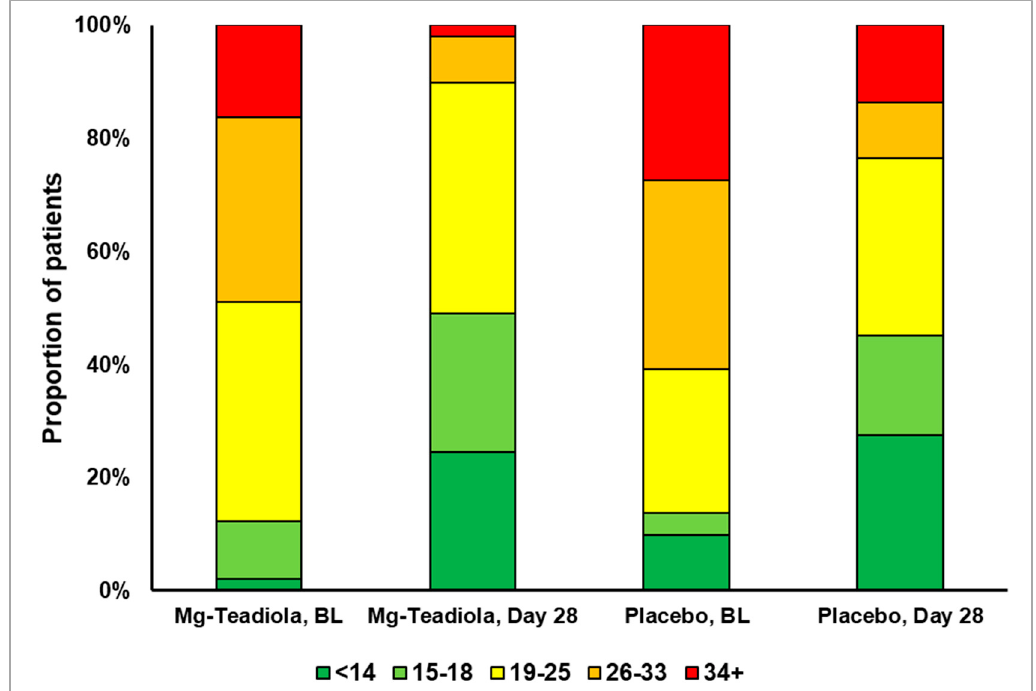
Figure 3. Proportion of participants with change in DASS-42 stress scores over time. BL, baseline; DASS, Depression Anxiety Stress Scale. Stress scores ranges: 0–14 (normal), 15–18 (mild), 19–25 (moderate), 26–33 (severe), and 34+ (extremely severe).